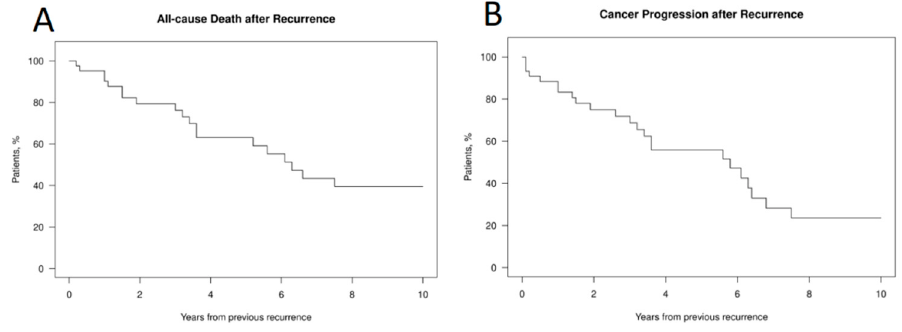
Figure 2. All-cause mortality after ENB recurrence ( A ) and cancer progression after recurrence ( B ).